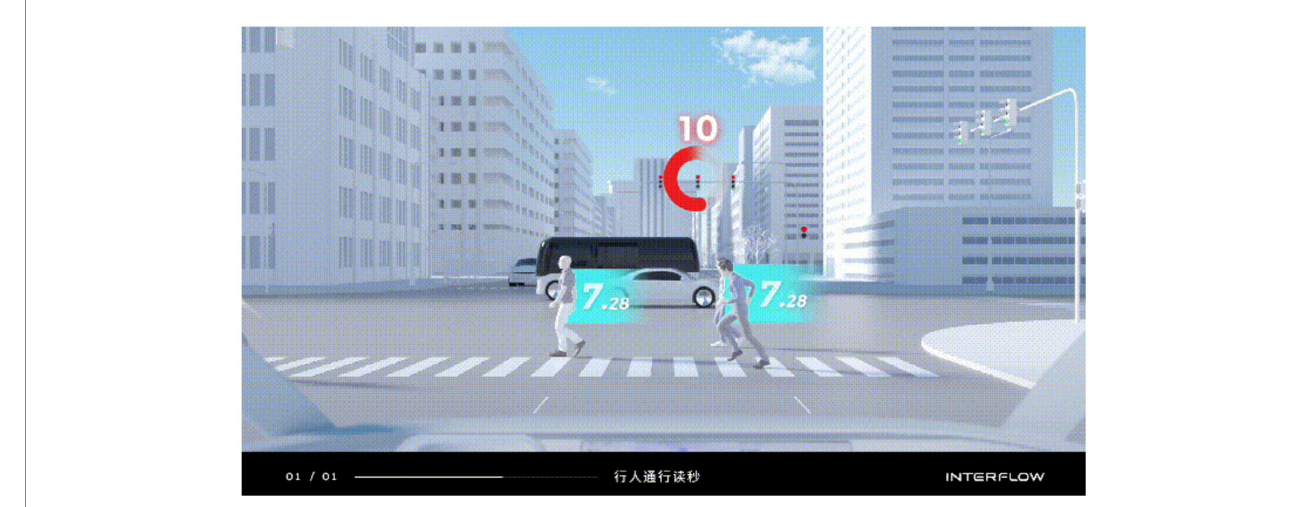
FIGURE 2 Video screenshot of the experimental material of the interaction mode.